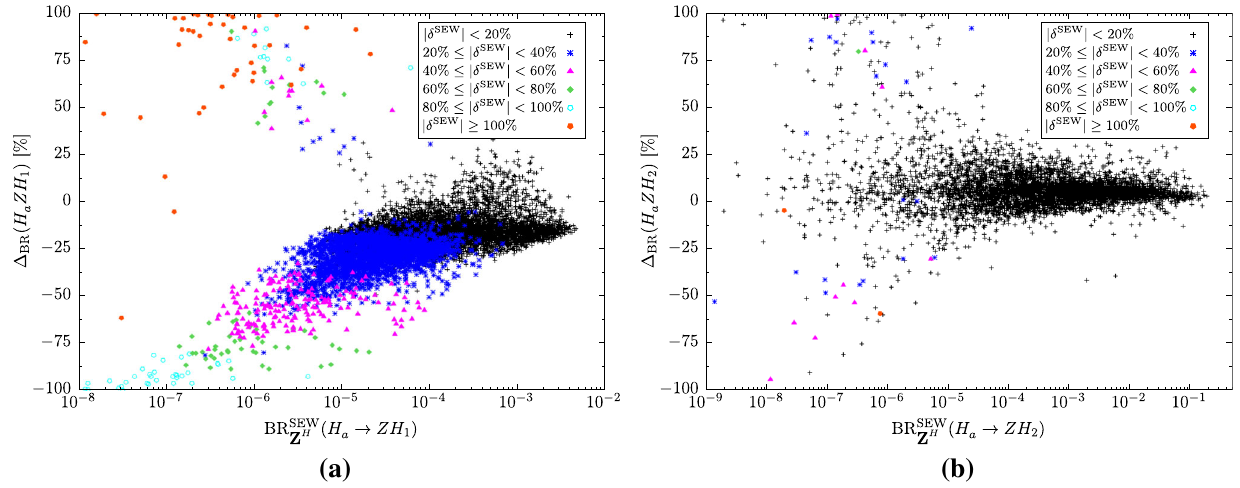
| δ SEW | < 20%; blue: 20 ≤ | δ SEW | < 40%; pink: 40 ≤ | δ SEW | < 60%;